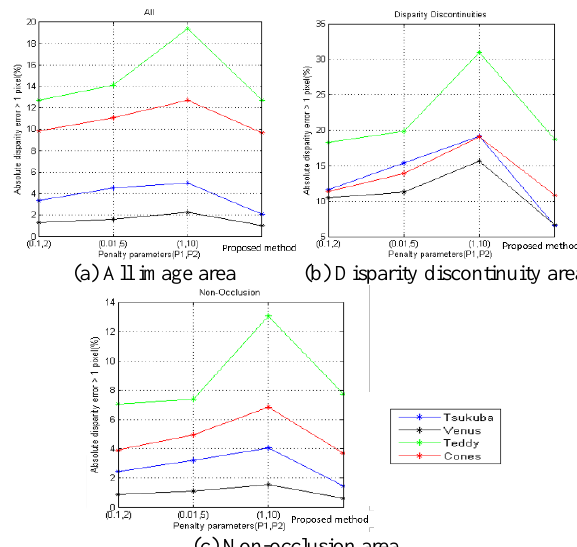
Figure 6. The proportion of the disparity error (> 1pixel).